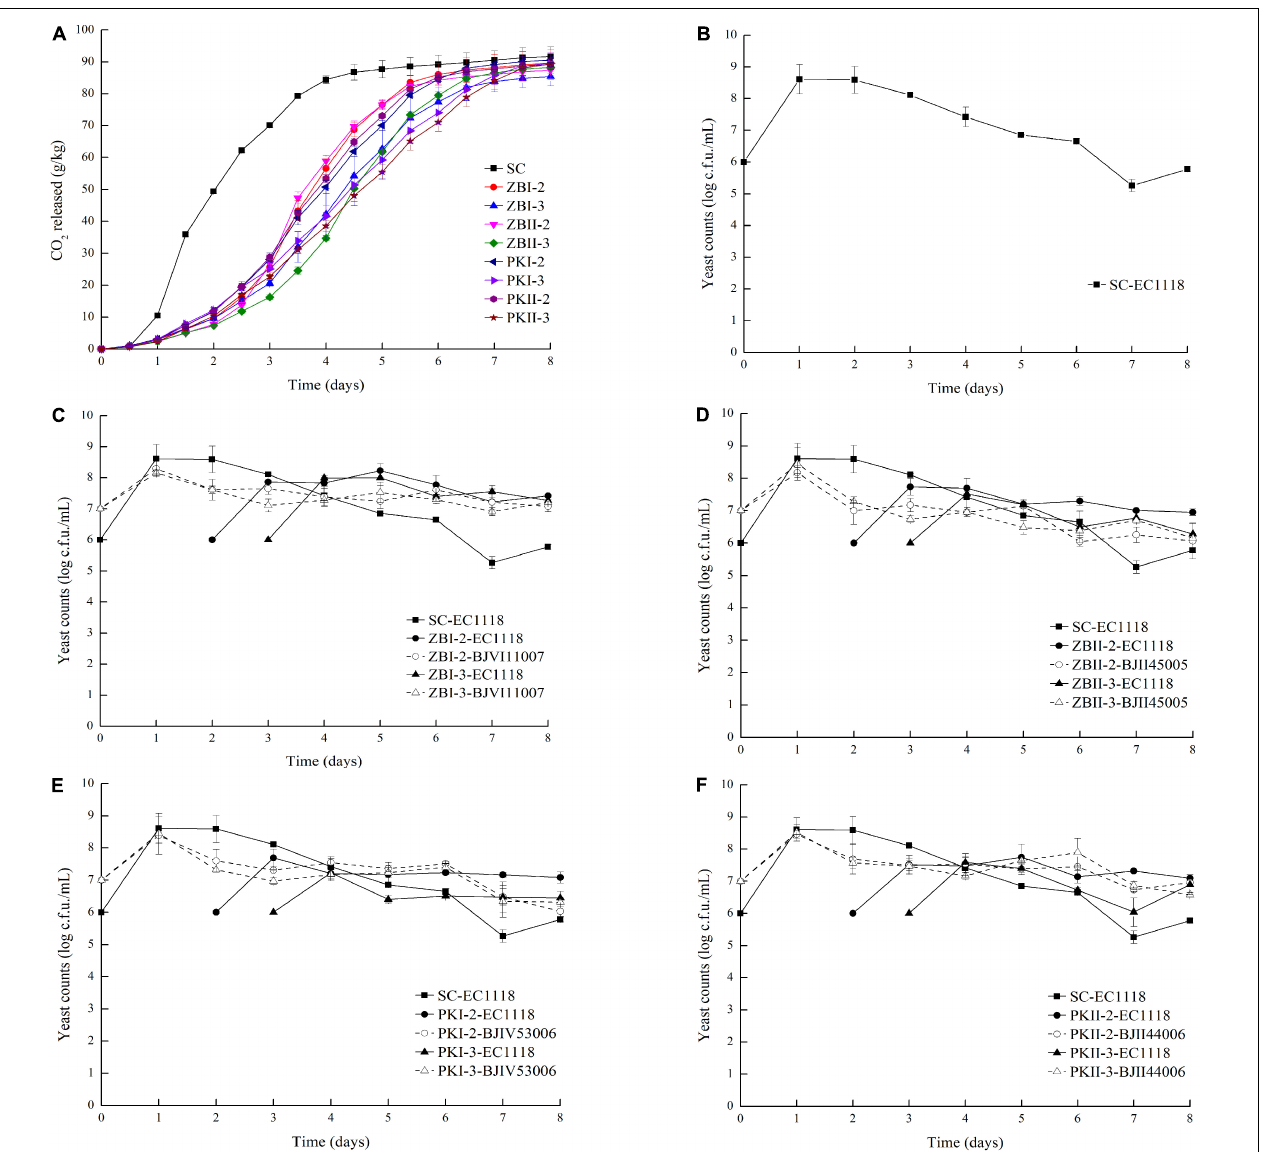
FIGURE 1 | CO 2 released and yeast population during alcoholic fermentation. (A) CO 2 released during alcoholic fermentation; (B) yeast population of S. cerevisiae EC1118 pure fermentation; (C) yeast population of Z. bailii BJVI11007/ S. cerevisiae EC1118 co-fermentation; (D) yeast population of Z. bailii BJII45005/ S. cerevisiae EC1118 co-fermentation; (E) yeast population of P. kudriavzevii BJIV53006/ S. cerevisiae EC1118 co-fermentation; (F) yeast population of P. kudriavzevii BJII44006/ S. cerevisiae EC1118